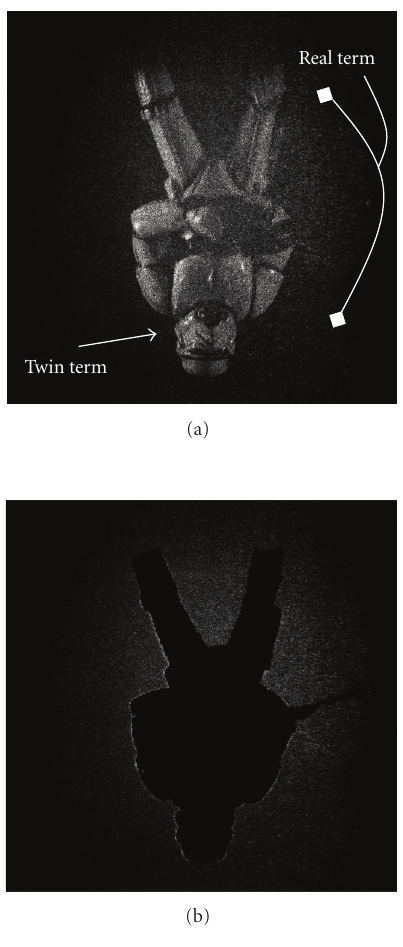
Figure 4: (a) This reconstruction is processed using the same hologram as that used to produce Figures 2 and 3. In this instance we forward propagate the hologram by a distance + z . In this instance the conjugate image is in focus and the real image term is out of focus. (b) This is the filter we use to remove the in-focus conjugate image.